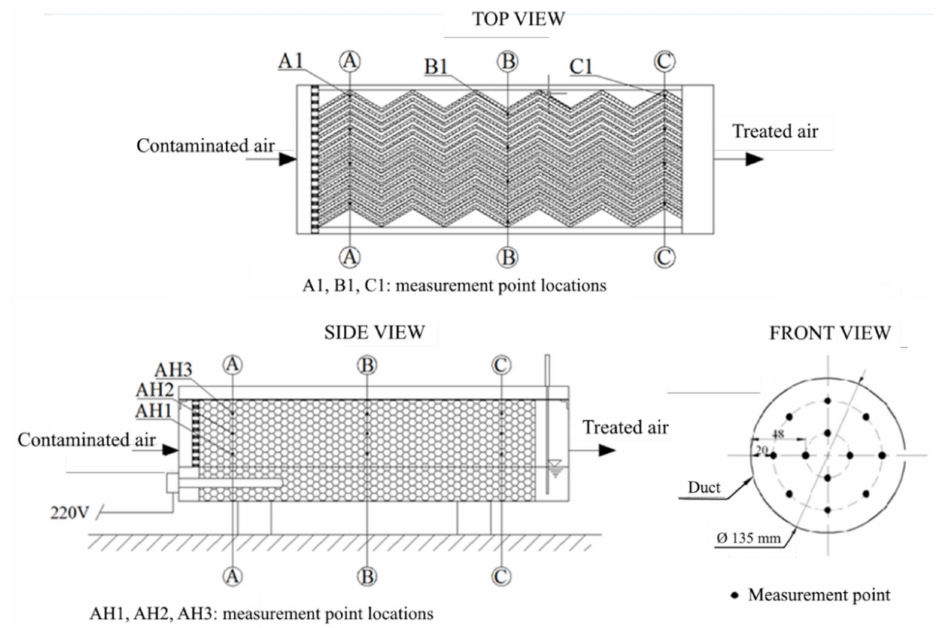
Figure 3. The pressure measurement points: across the packing material (top and side views) and in the cross section of the inlet and outlet ducts (front